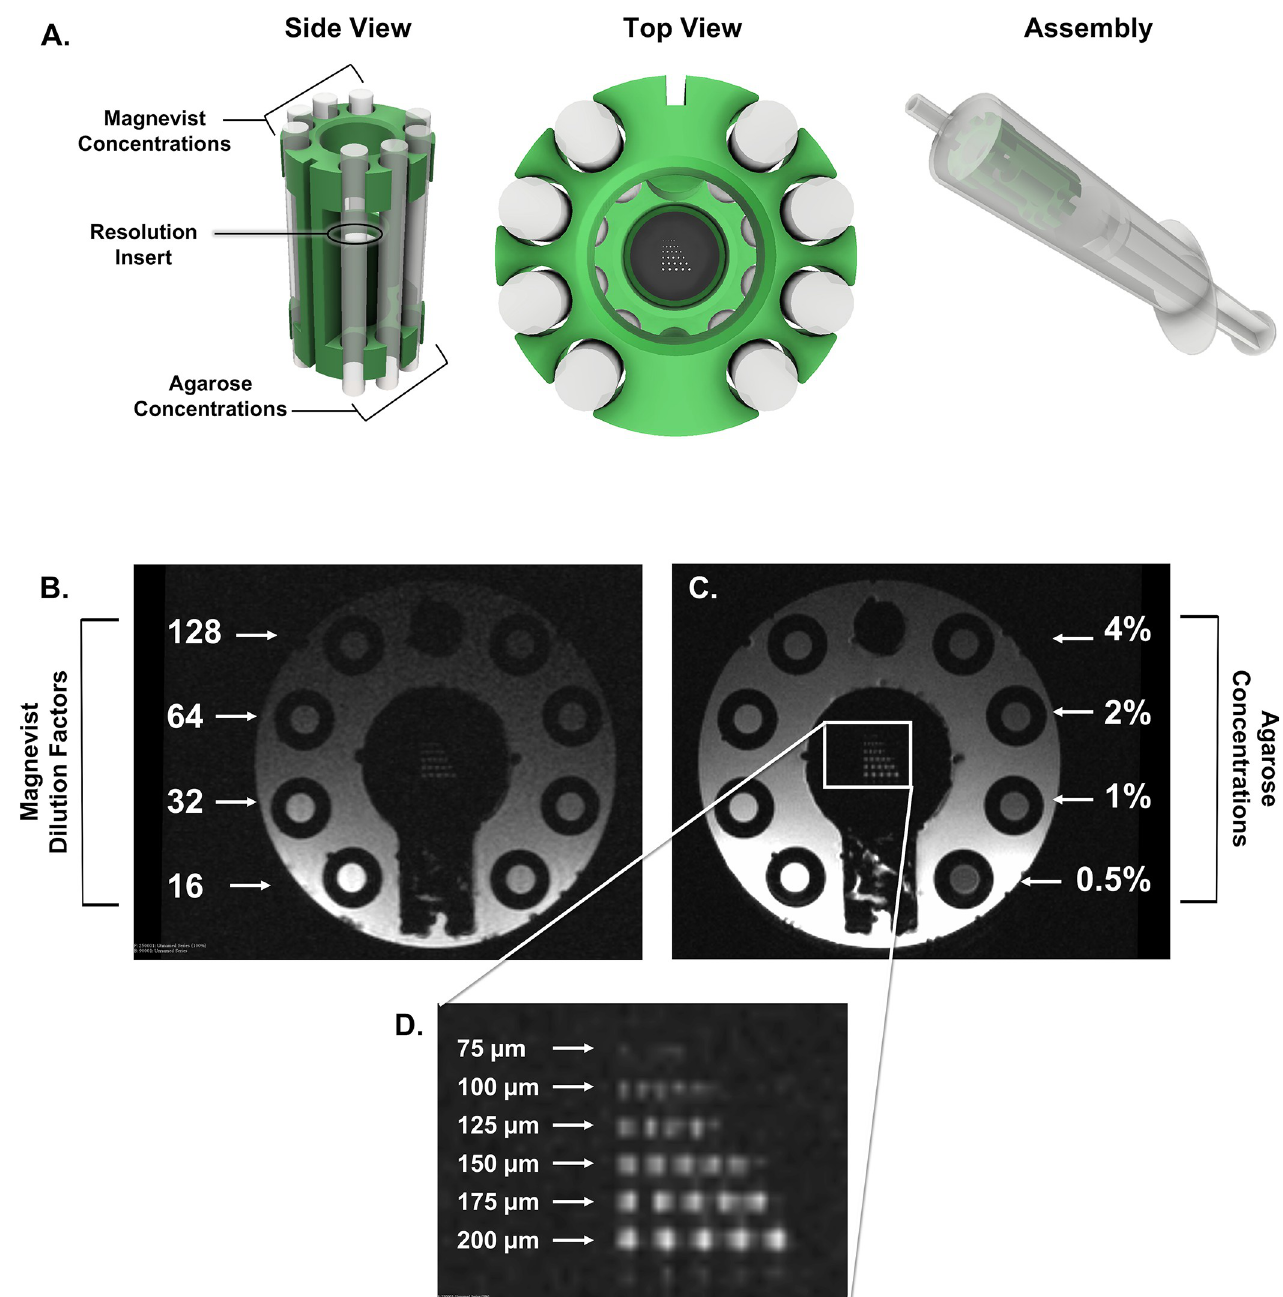
Fig 4. A custom study phantom demonstrates T1 + T2 range and resolution for mouse sarcoma imaging. A 3D-printed phantom was designed to hold tubes containing a range of magnevist (T1) and agarose (T2) concentrations, as well as a resolution insert, and was loaded into a syringe filled with water (A). The T1 sequence used in the preclinical trial demonstrates the range of T1 signal within predetermined magnevist concentrations (B), where dilution factor refers to the dilution of a 1% solution in deionized water. The T2 sequence used in the preclinical trial demonstrates the range of T2 signal within predetermined agarose gel concentrations (C). The resolution insert confirms sufficient resolution of the sequences down to 100um (D). Images shown have not been altered or corrected for bias.